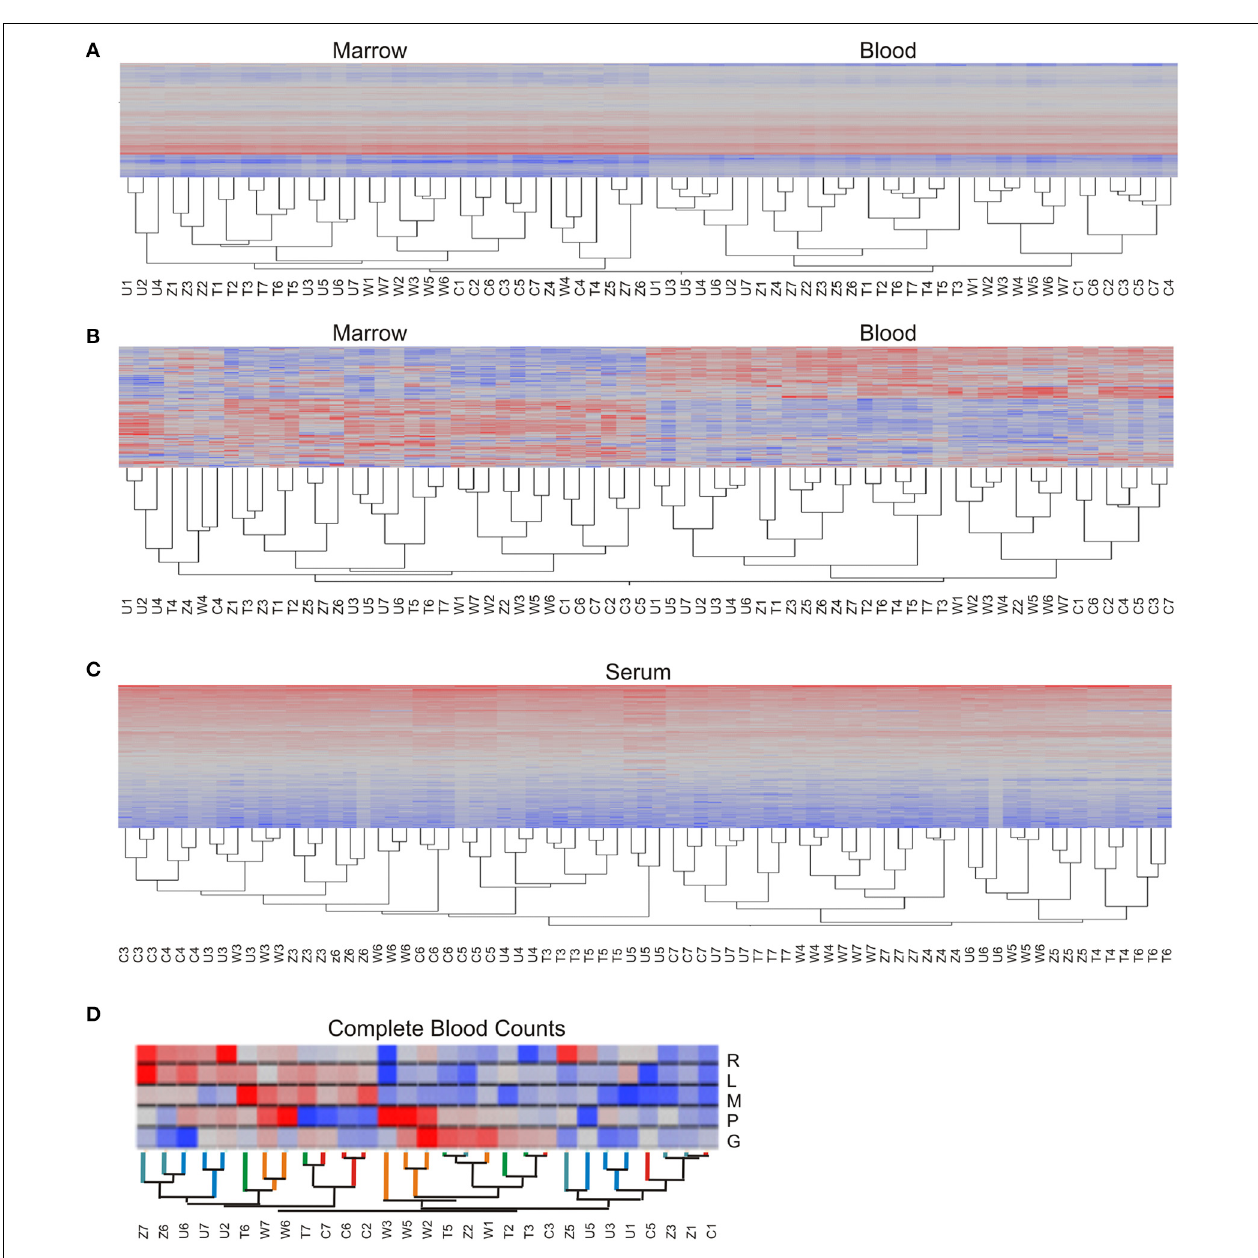
FIGURE 3 | Two-way hierarchical clustering. Each heat map shows the abundance of each transcript or metabolite (rows) in each sample (column) with red indicating high expression, blue low, gray intermediate. (A) Transcriptome, based on absolute log-2 intensity estimates, and (B) based on standardized log-2 intensities, in both cases combining both BM and PB in the same clustering. (C) Plasma metabolome, where each column is a technical replicate, showing